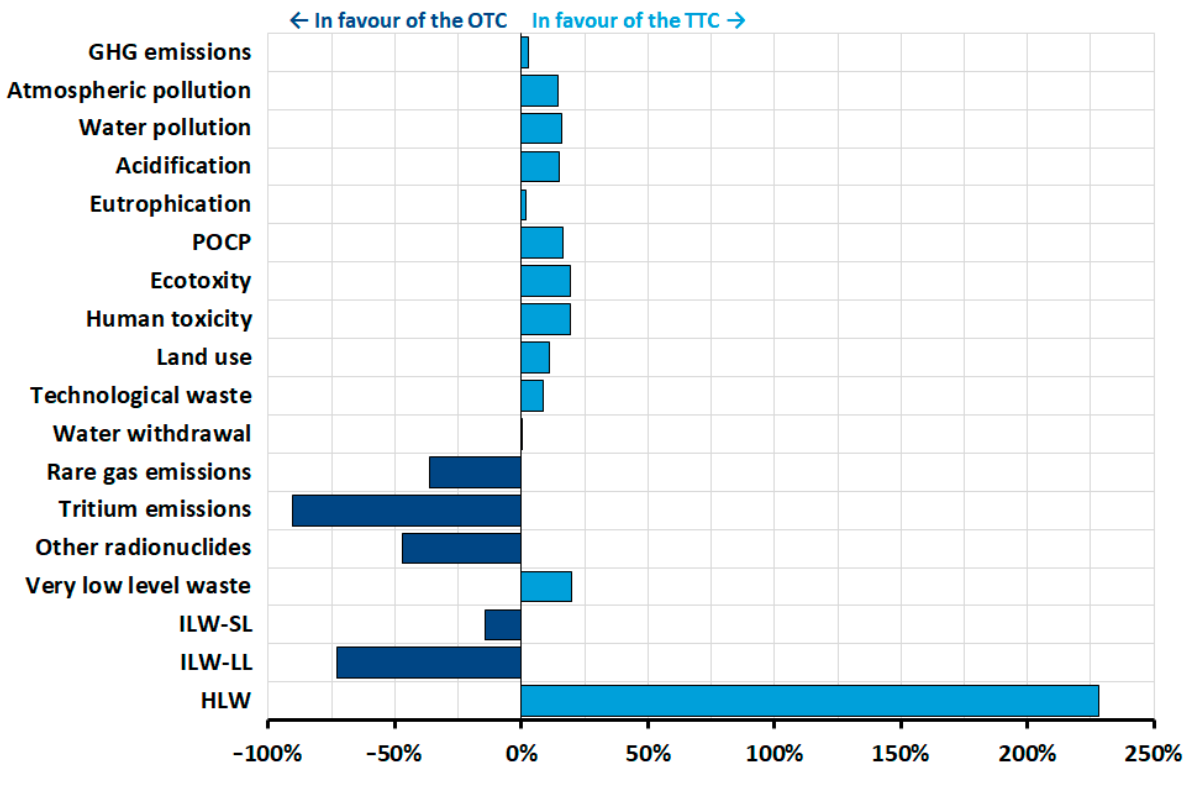
Figure 7. Evolution of the impact indicators when going from the French TTC to an OTC producing the same amount of electricity with the same PWR fleet. Redrawn from data in [50].